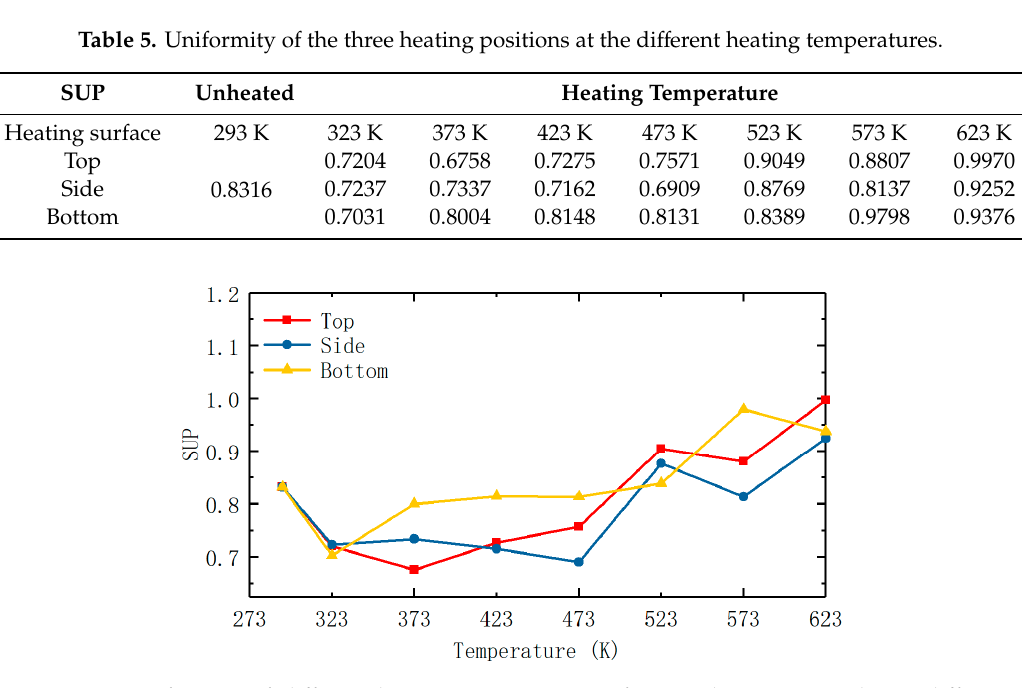
Figure 6. Uniformity of different heating temperatures of internal mixing nozzles at different heating modes.